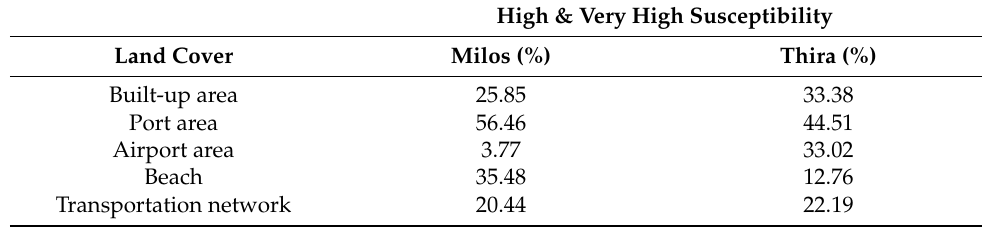
Table 11. Multi-hazard susceptibility statistics in Milos and Thira islands regarding the natural and manmade